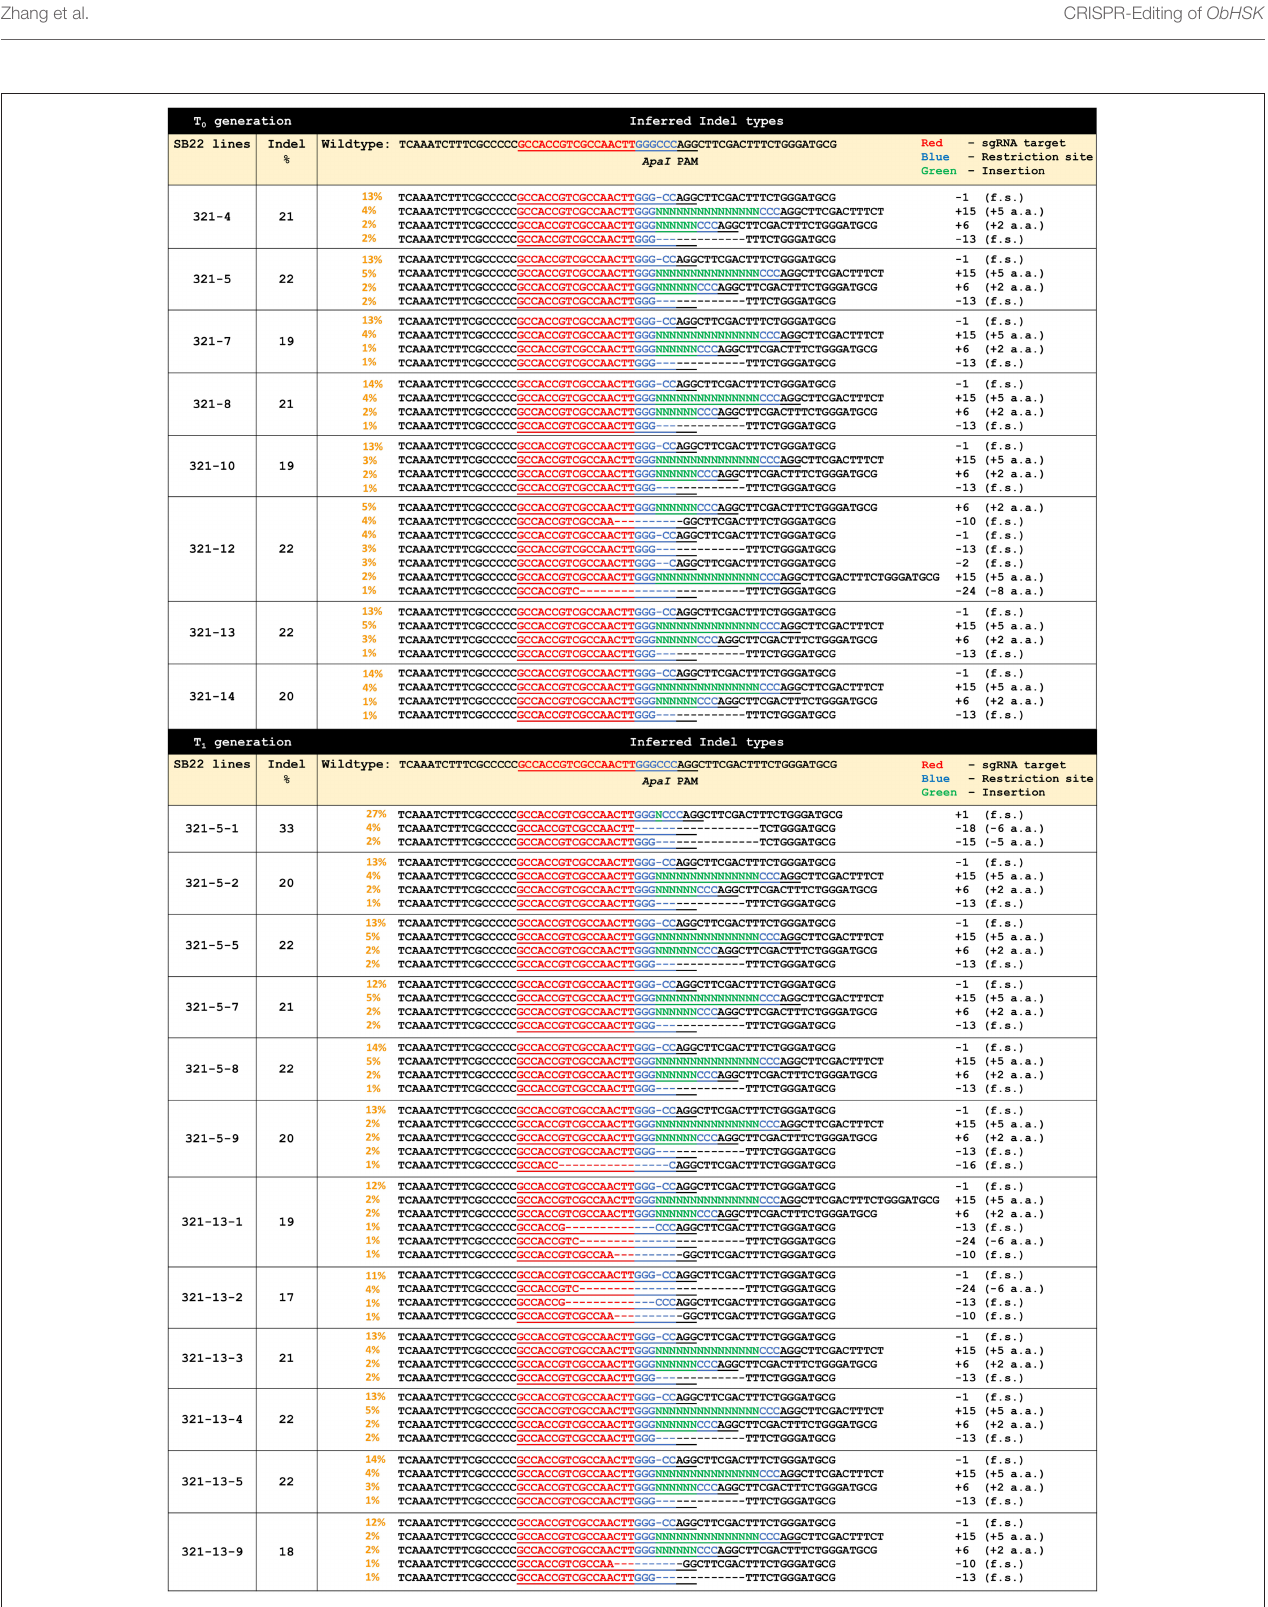
FIGURE 3 | Gene editing profiles generated by ICE analysis for individual T 0 and T 1 ObHSK -edited sweet basil plants. “ + ” indicates addition of nucleotide base (N). “–” indicates deletion of nucleotide base. “f.s.” indicates frameshifting mutations. “PAM” (AGG) indicates the protospacer adjacent motif for Cas9. “a.a.” stands for amino